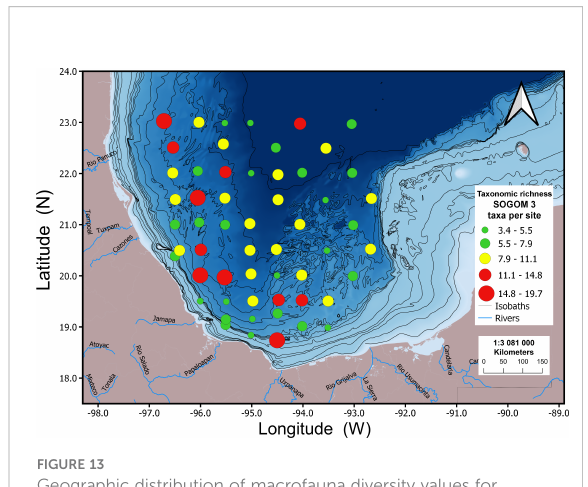
FIGURE 13 Geographic distribution of macrofauna diversity values for SOGOM 3.